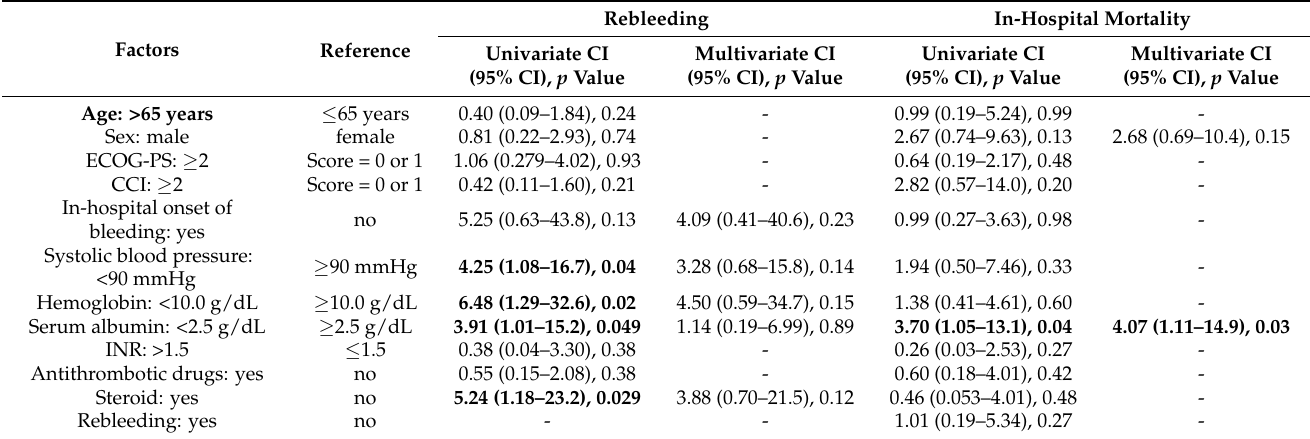
Table 5. Factors associated with re-bleeding and in-hospital mortality among patients with